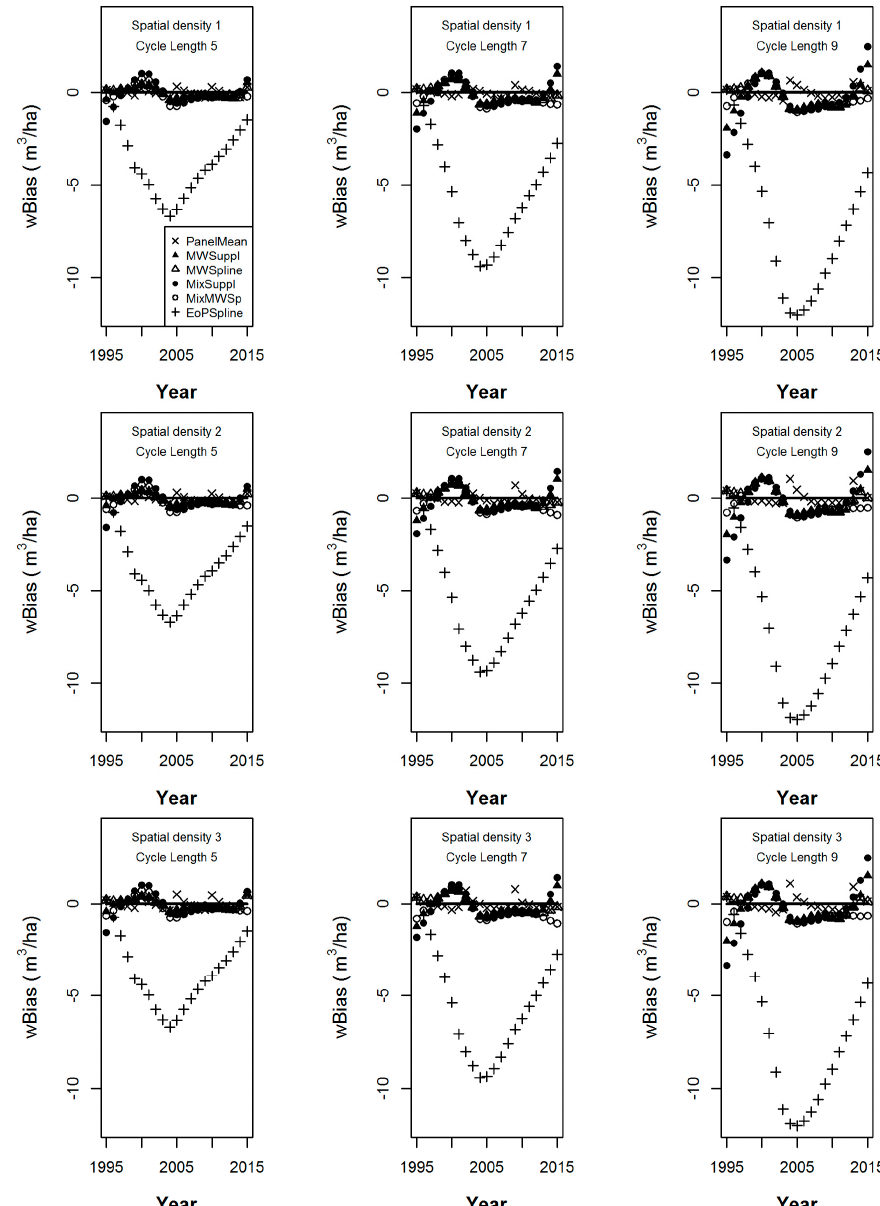
Figure 3. The weighted bias of six volume estimators, the panel mean, the supplemented moving window, the splined moving window, the supplemented mixed estimator, the moving window-splined mixed estimator, and the splined EoP estimator from the simulation over the 152 populations under spatial sampling intensities 1 through 3 (top to bottom) and cycle lengths of 5, 7 and 9 years (left to right).